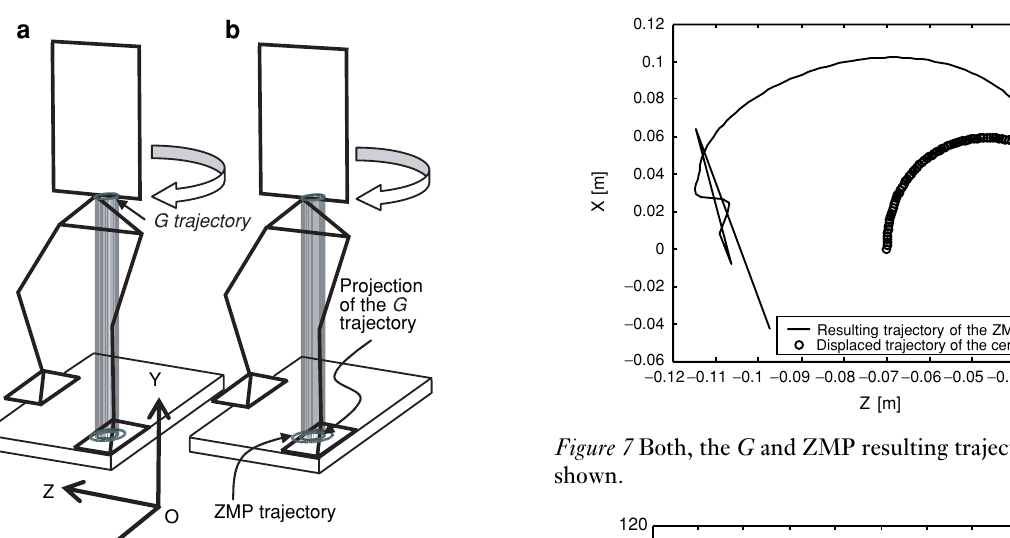
Figure 7 Both, the G and ZMP resulting trajectories are shown.